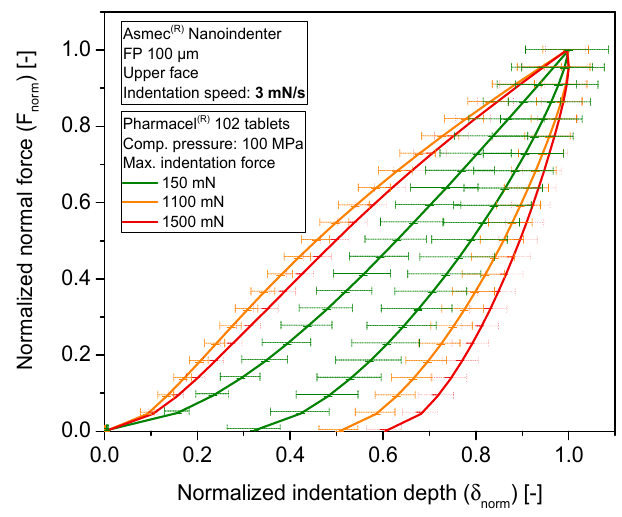
Figure 12. Normalized force–displacement indentation curves. Confidence intervals for n = 30 assuming normally distributed results for a 95% of probability. Material: MCC-P. Compaction pressure: 100 MPa.